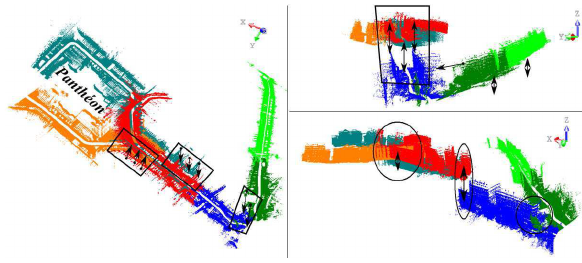
Fig. 2. Discrepancies between road sections produced by Mobile Mapping System : Lara3D.